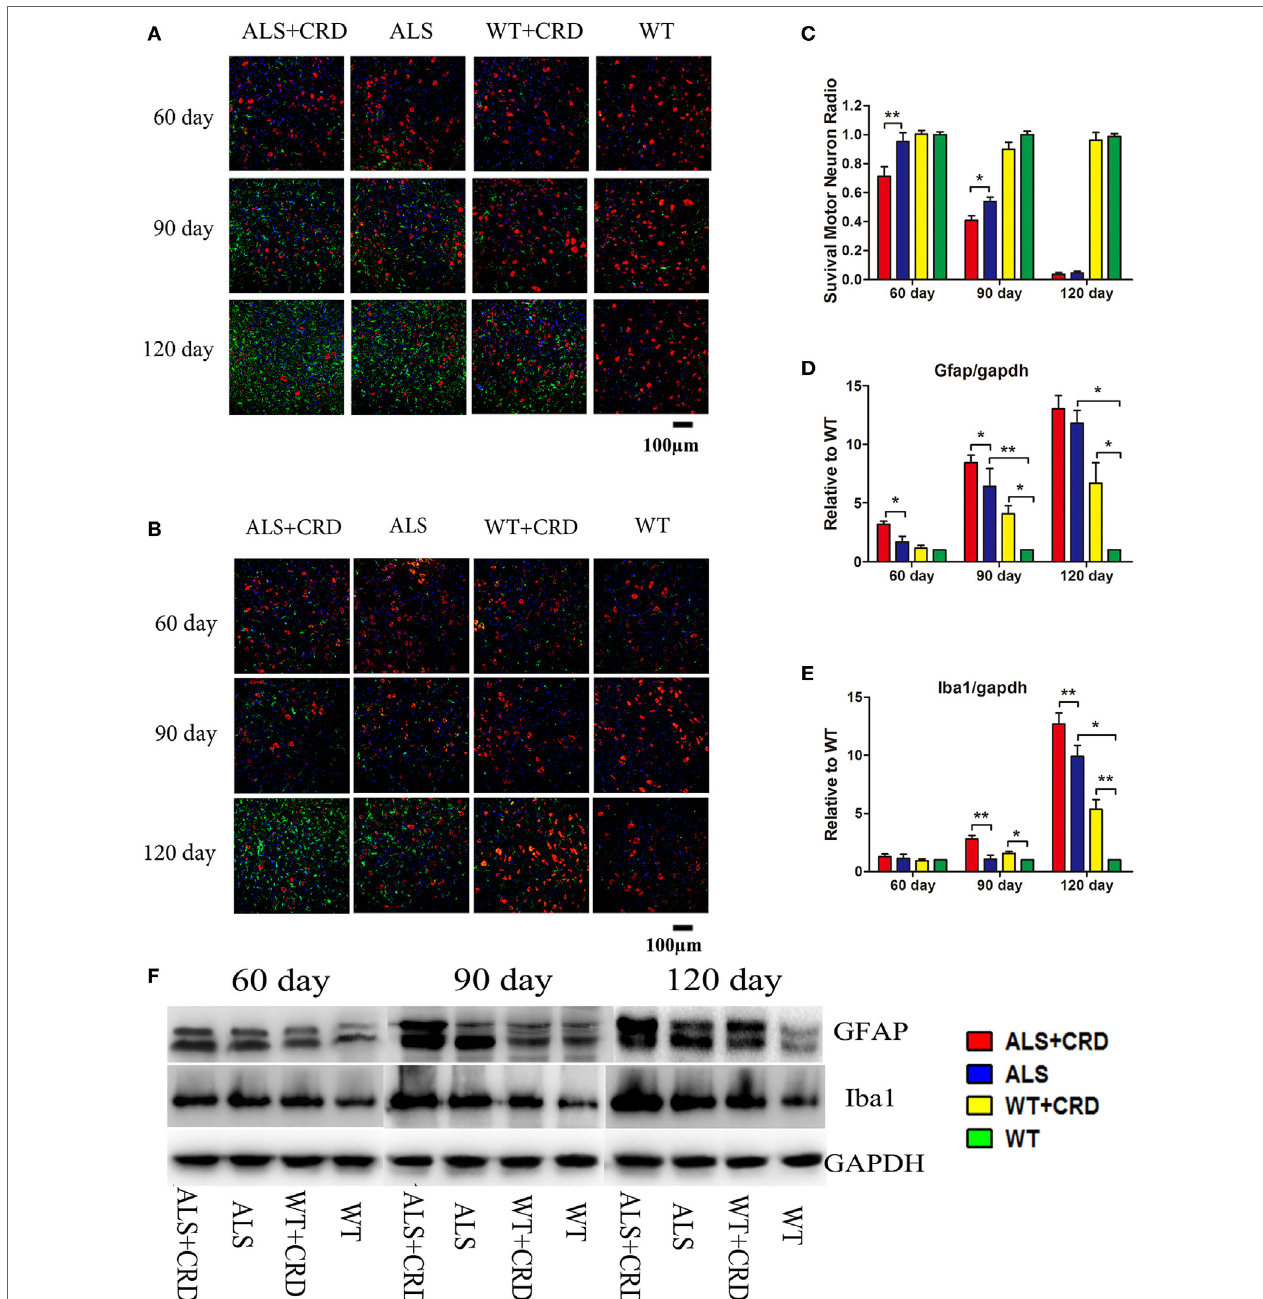
FigUre 2 | Circadian rhythm dysfunction (CRD) aggravated motor neuron (MN) loss and activated glial cells in SOD1G93A mice. (a) MNs [choline acetyltransferase (ChAT)-positive cells, red] and astrocytes [glial fibrillary acidic protein (GFAP)-positive cells, green] expression in four groups for three stages. (B) MNs (ChAT-positive cells, red) and microcytes (Iba1-positive cells, green) expression in four groups for three stages. Scale bars represent 100 µm. (c) Statistical evaluation of surviving MNs radio by counting the number of ChAT-positive cells. ** p < 0.01; * p < 0.05 (one-way ANOVA, n = 4–6 animals per group). (D,e) GFAP and Iba1 expression was quantified at three stages by western blotting (one-way ANOVA, n = 2–3 animals per group). (F) Expression of GFAP and Iba1 in the spinal cord. ** p < 0.01; * p < 0.05. Error bars represent